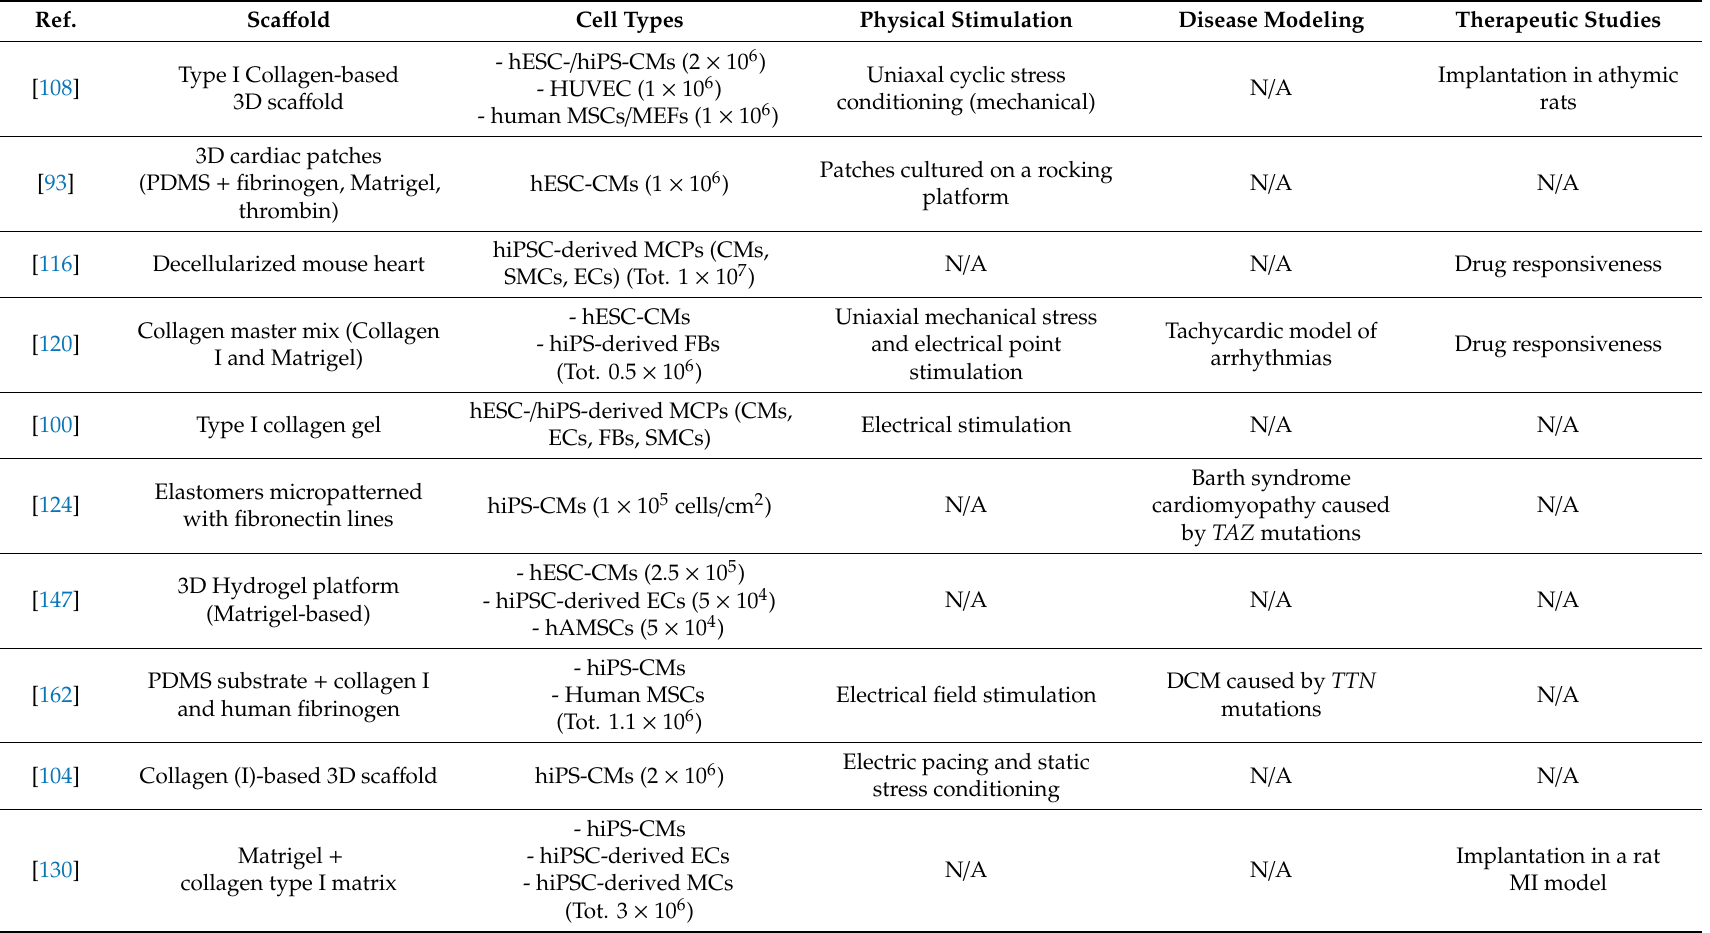
Table 3. List of 3D hiPSC-based cardiac constructs reported in this